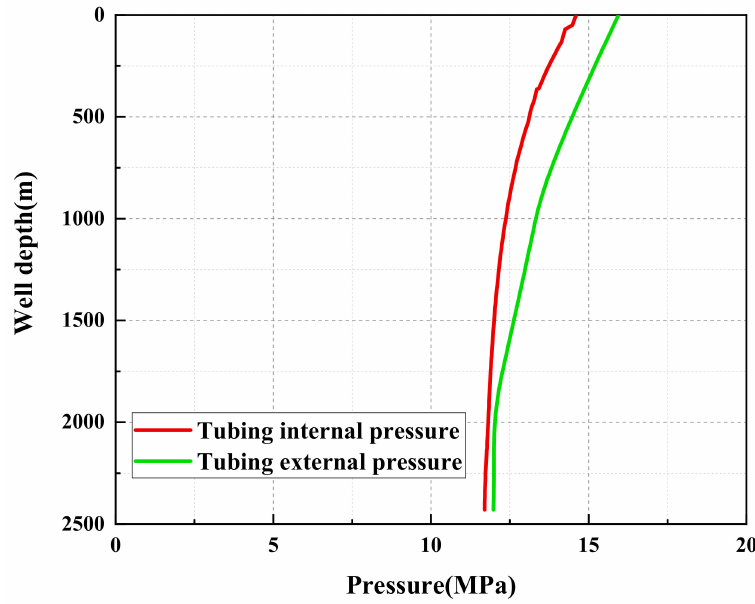
Figure 9. Pressure distribution of the integrated injection-production